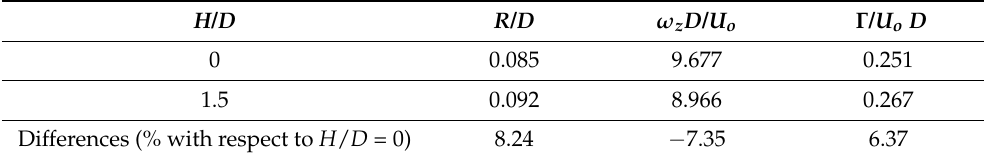
Table 3. Flow characteristics of the HSV: ensemble-averaged radius ( R/D ), core vorticity ( ω z D/U o ), and circulation ( Γ /U o D ) at the “oscillation with a small displacement” mode when H / D = 0 and 1.5. H/D R/D ω z D/U o Γ / U o D 0 0.085 9.677 0.251 1.5 0.092 8.966 0.267 Differences (% with respect to H / D = 0) 8.24 − 7.35